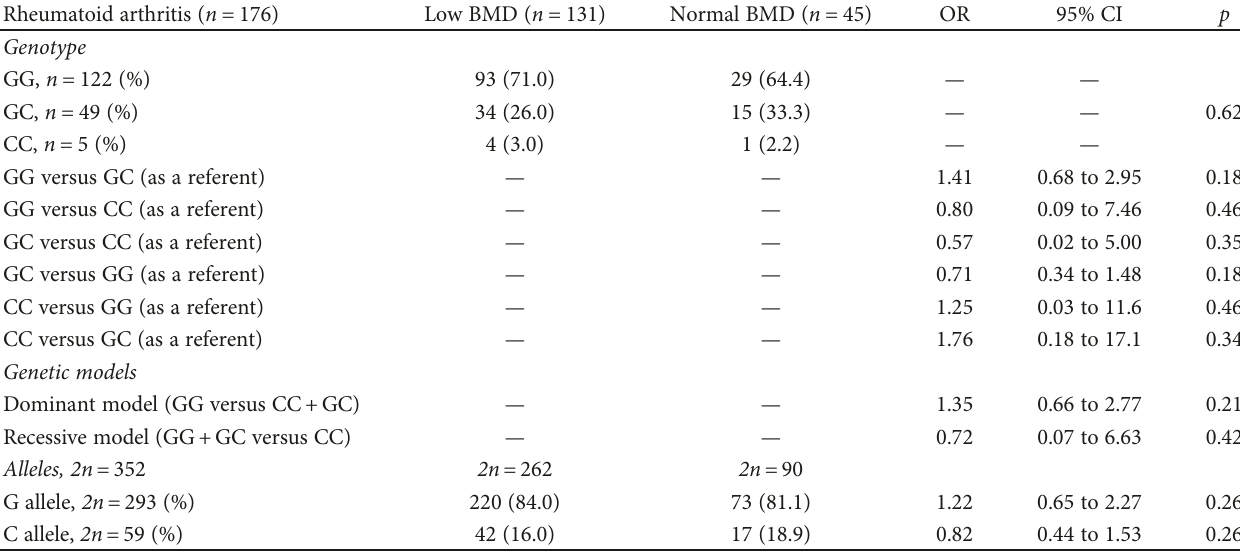
Table 3: Evaluation of the rs2073618 polymorphism as a predictor of low bone mineral density (BMD) in patients with rheumatoid arthritis (RA).